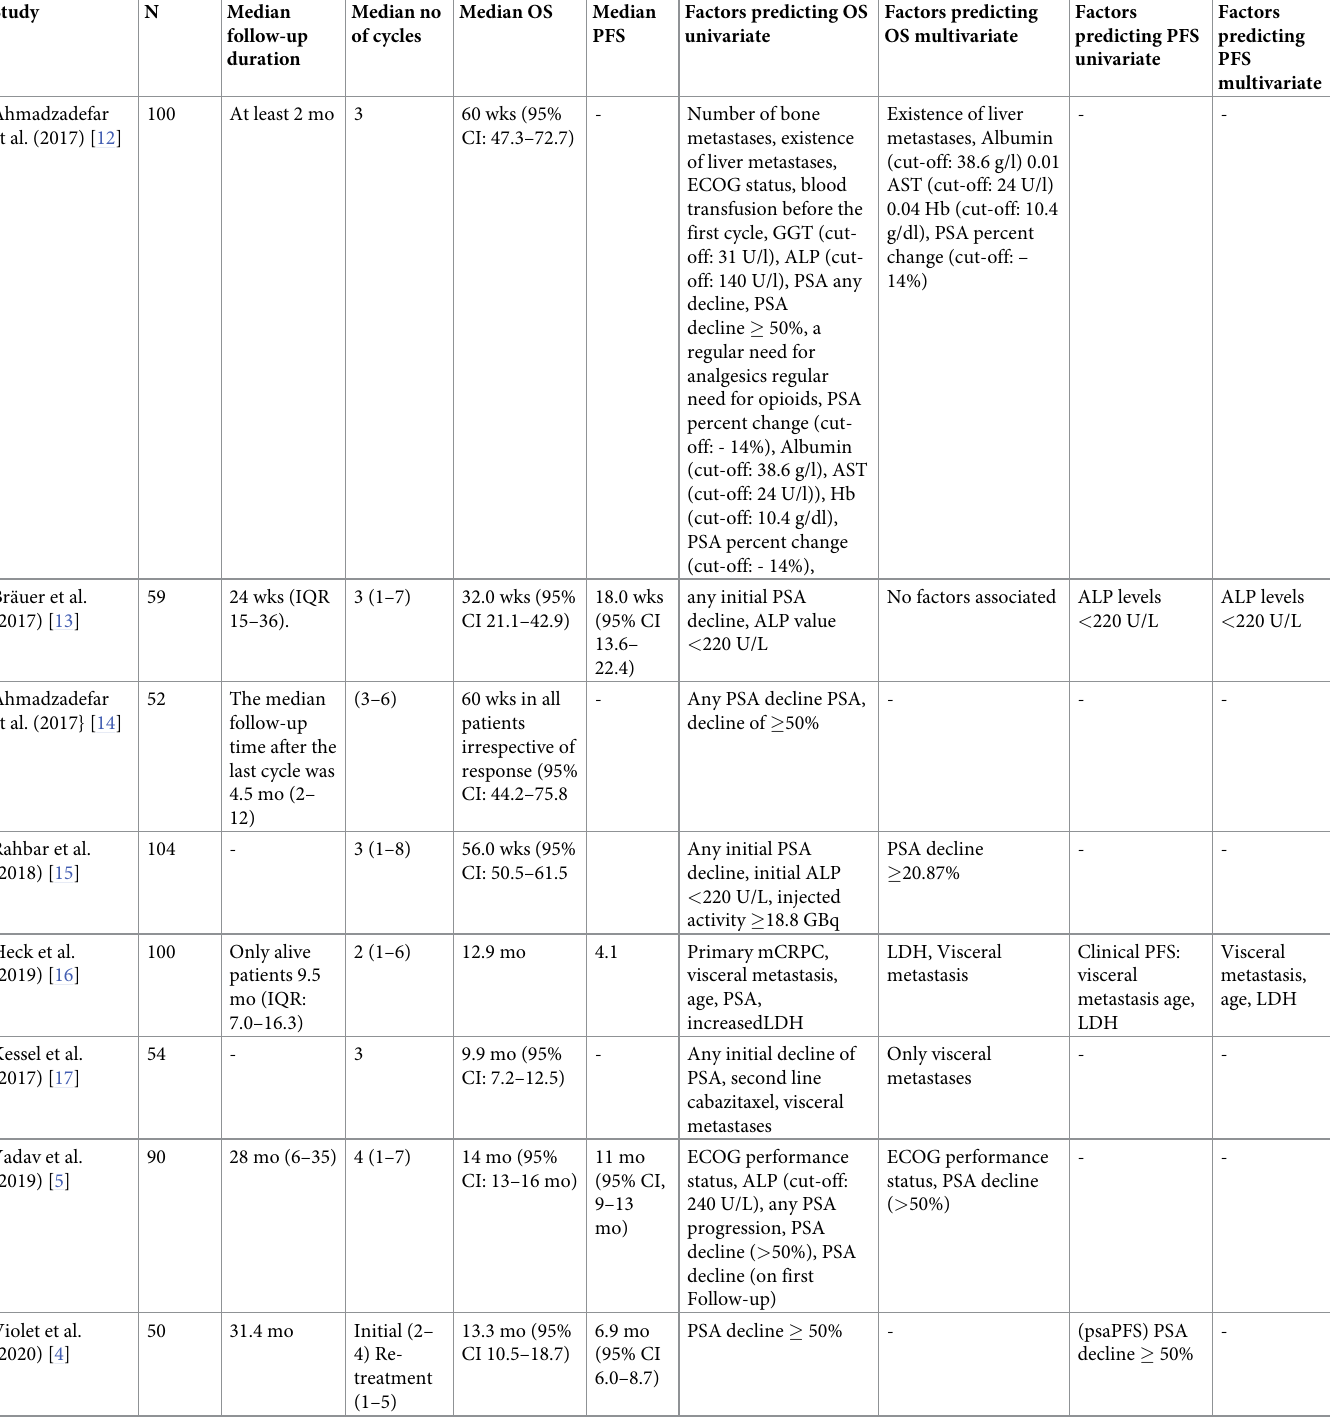
Table 7. Studies reporting the factor predicting the OS and